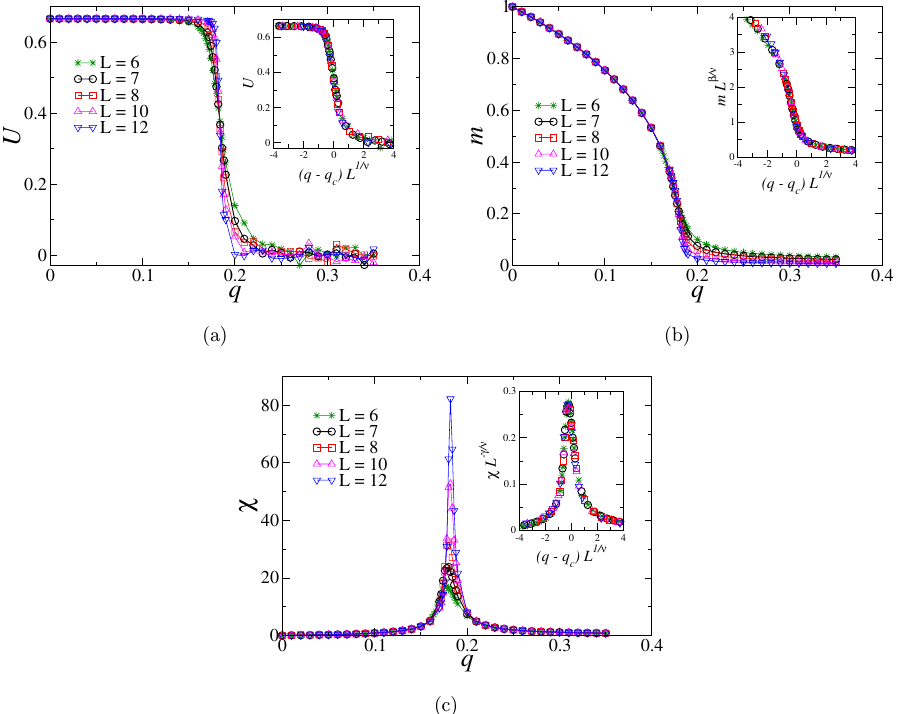
Fig. 6. Binder cumulant U (a), order parameter m (b) and susceptibility (cid:5) (c) as functions of the independence probability q for the symmetric case ( g ¼ 1 = 3 ) on 4D hypercubic lattices for di®erent lattice sizes L . In the inset, we exhibit the corresponding scaling plots. The estimated critical quantities are q c (cid:3) 0 : 183 , (cid:2) (cid:3) 0 : 48 , (cid:3) (cid:3) 1 : 02 and (cid:4) (cid:3) 0 : 51 . Results are averaged over 200, 170, 120, 100 and 100 samples for L ¼ 6 ; 7 ; 8 ; 10 and 12,